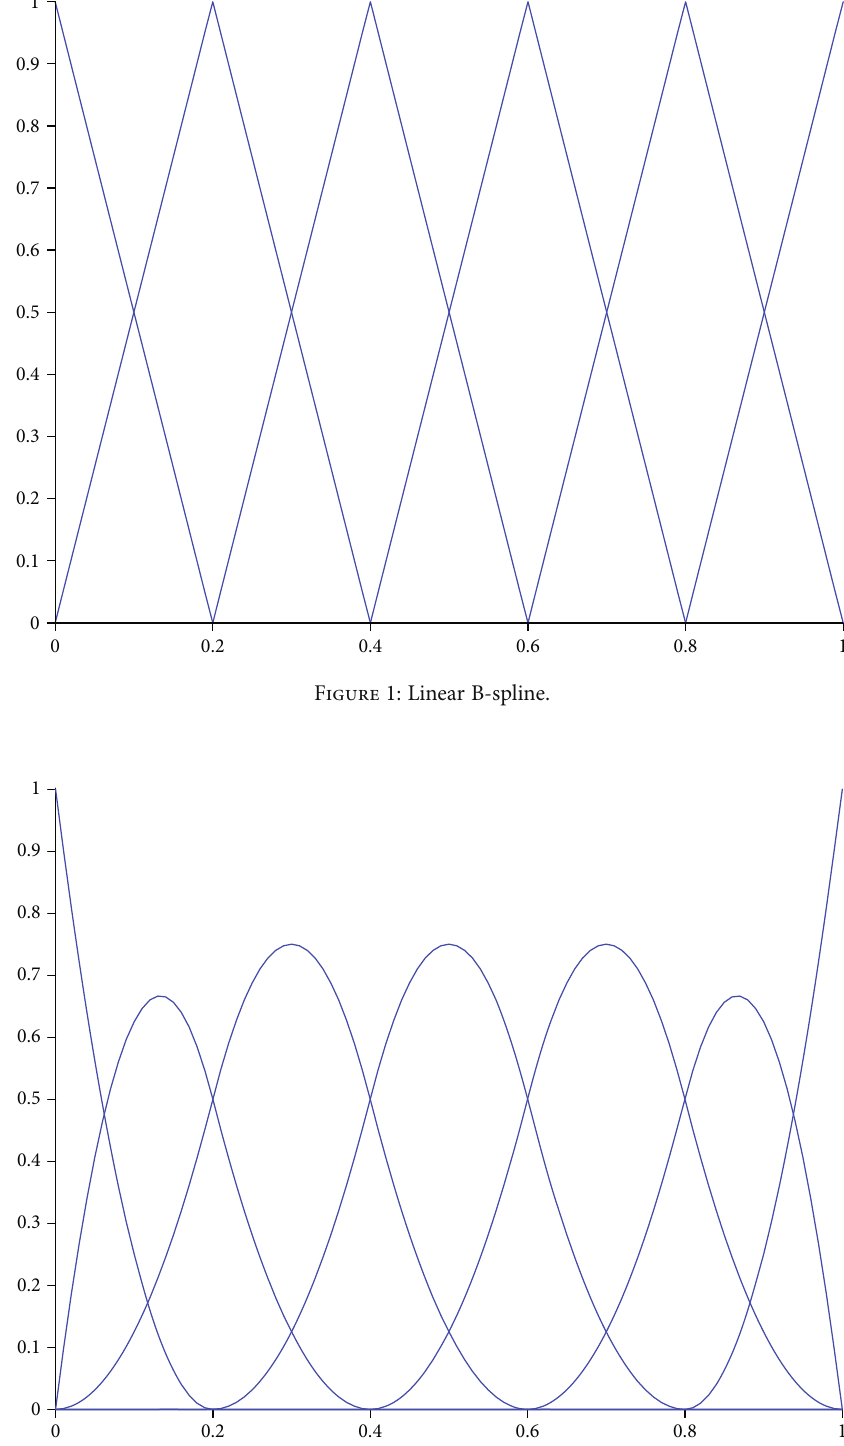
Figure 2: Quadratic